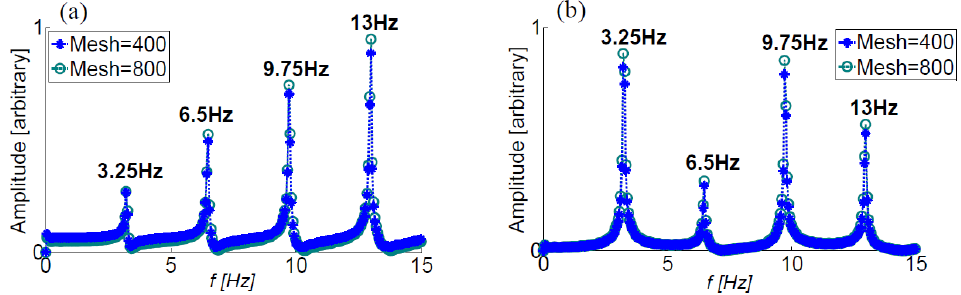
Figure 3. The FFT of the pressure signals at the entrance to the first ( a ) and the second ( b ) vessels calculated for the three equal-length vessels configuration (III-a, Table 1). Mesh refinement study results are also